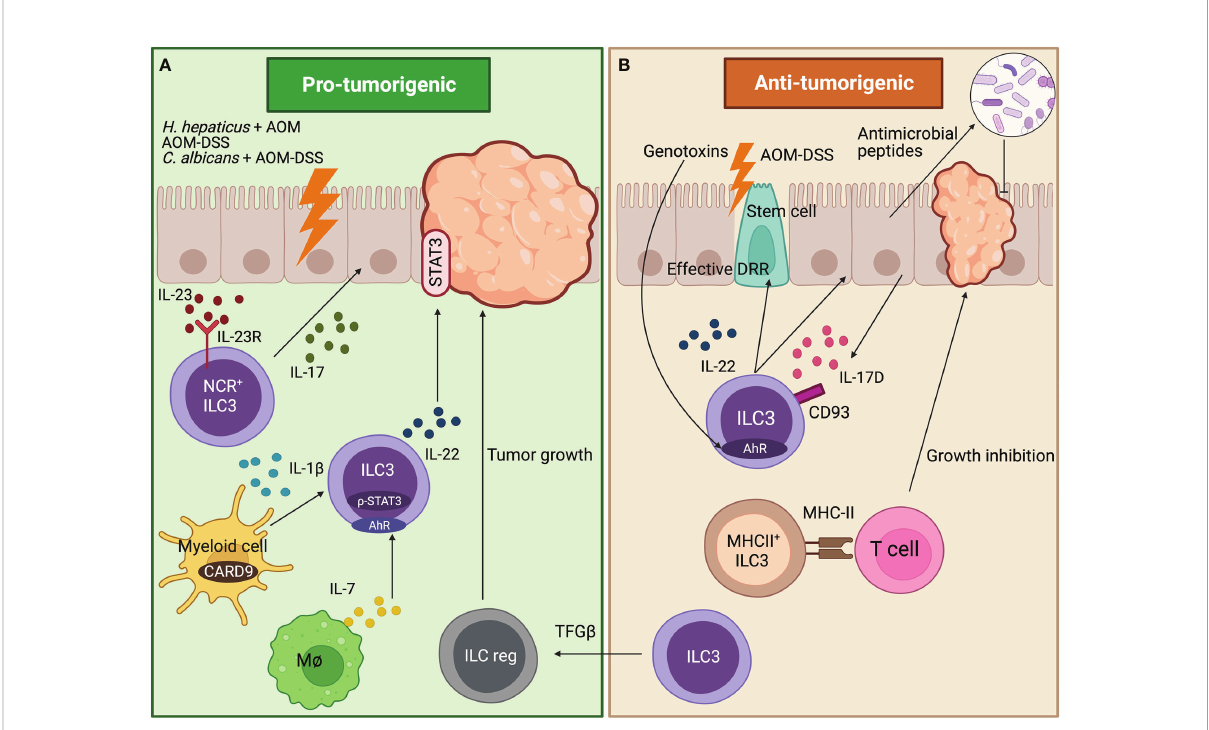
FIGURE 1 Role of ILC3s in tumors developed in the gut. (A) Pro-tumorigenic effects of ILC3s. In a duodenum murine cancer model, NCR + ILC3s drive tumorigenesis by secreting IL-17 which is induced by IL-23 binding to IL-23R. In the AOM-DSS CAC model, myeloid cells regulate the IL-22 production by ILC3s in a CARD9-IL-1 b -dependent, thus promoting carcinogenesis. Fungal stimulated macrophages release IL-7, which promotes IL-22 secretion from ILC3s through AhR and p-STAT3 in the C.albicans AOM-DSS cancer model, thus triggering CAC formation. In H. hepaticus + AOM CAC model, ILC3s-derived IL-22 promotes and maintains tumor formation through STAT3 phosphorylation in IECs. (B) Anti- tumorigenic effects of ILC3s. In AOM-DSS cancer model, IL-17D secreted by IECs binds to ILC3s through CD93 receptor regulating ILC3s IL-22 secretion. This shapes the colon microbiome through IECs antimicrobial peptide secretion, thus inhibiting cancer formation. Intestinal stem cells are protected from genotoxins through the AhR-IL-22 axis that regulates the DDR, avoiding the initiation of colonic cancer. In the AOM-DSS CAC model, MHC-II + ILC3s (CCR6 + Lti-like cells) interact with T cells through MHC-II avoiding cancer formation. Moreover, in the AOM-DSS model, blocking the TGF- b -driven transdifferentiation of ILC3s (NKp46 + ) to ILCreg inhibits tumor